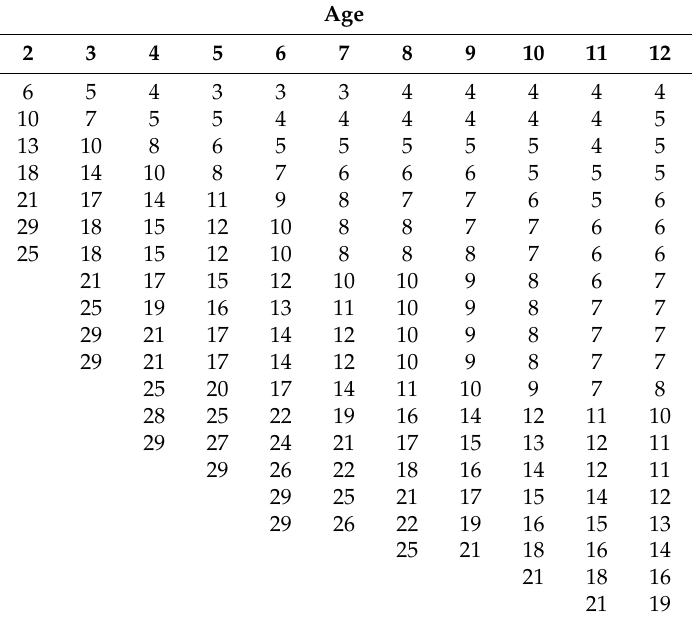
Table 4. Sensory/Cognitive awareness subscale score norms as a function of the initial score and age from Figure